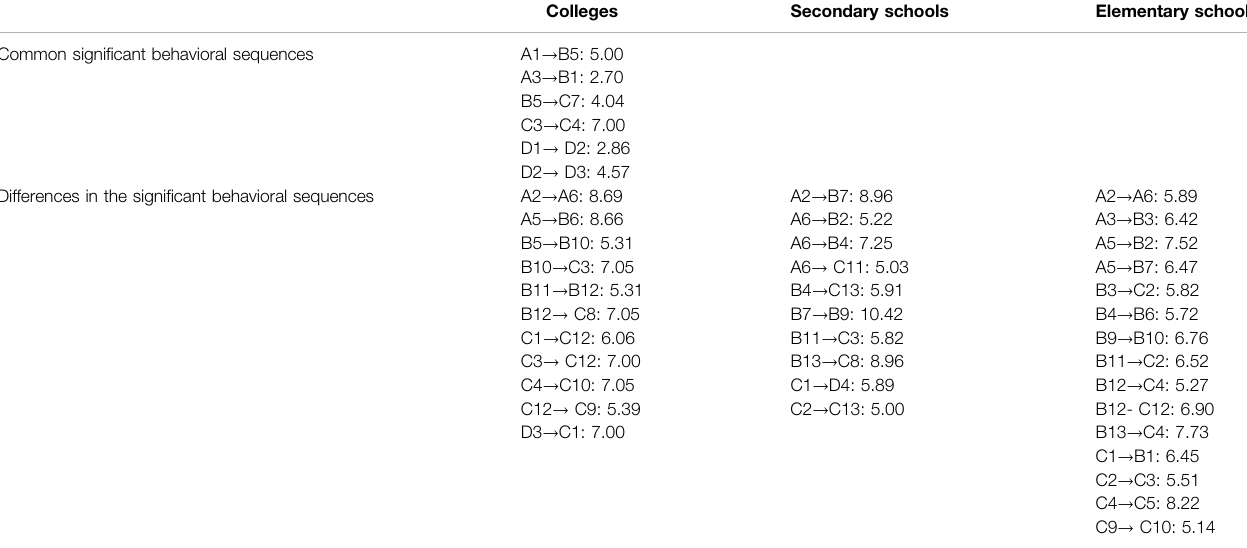
TABLE 3 | Signi fi cant behavioral sequences (similarities and differences Z-score >